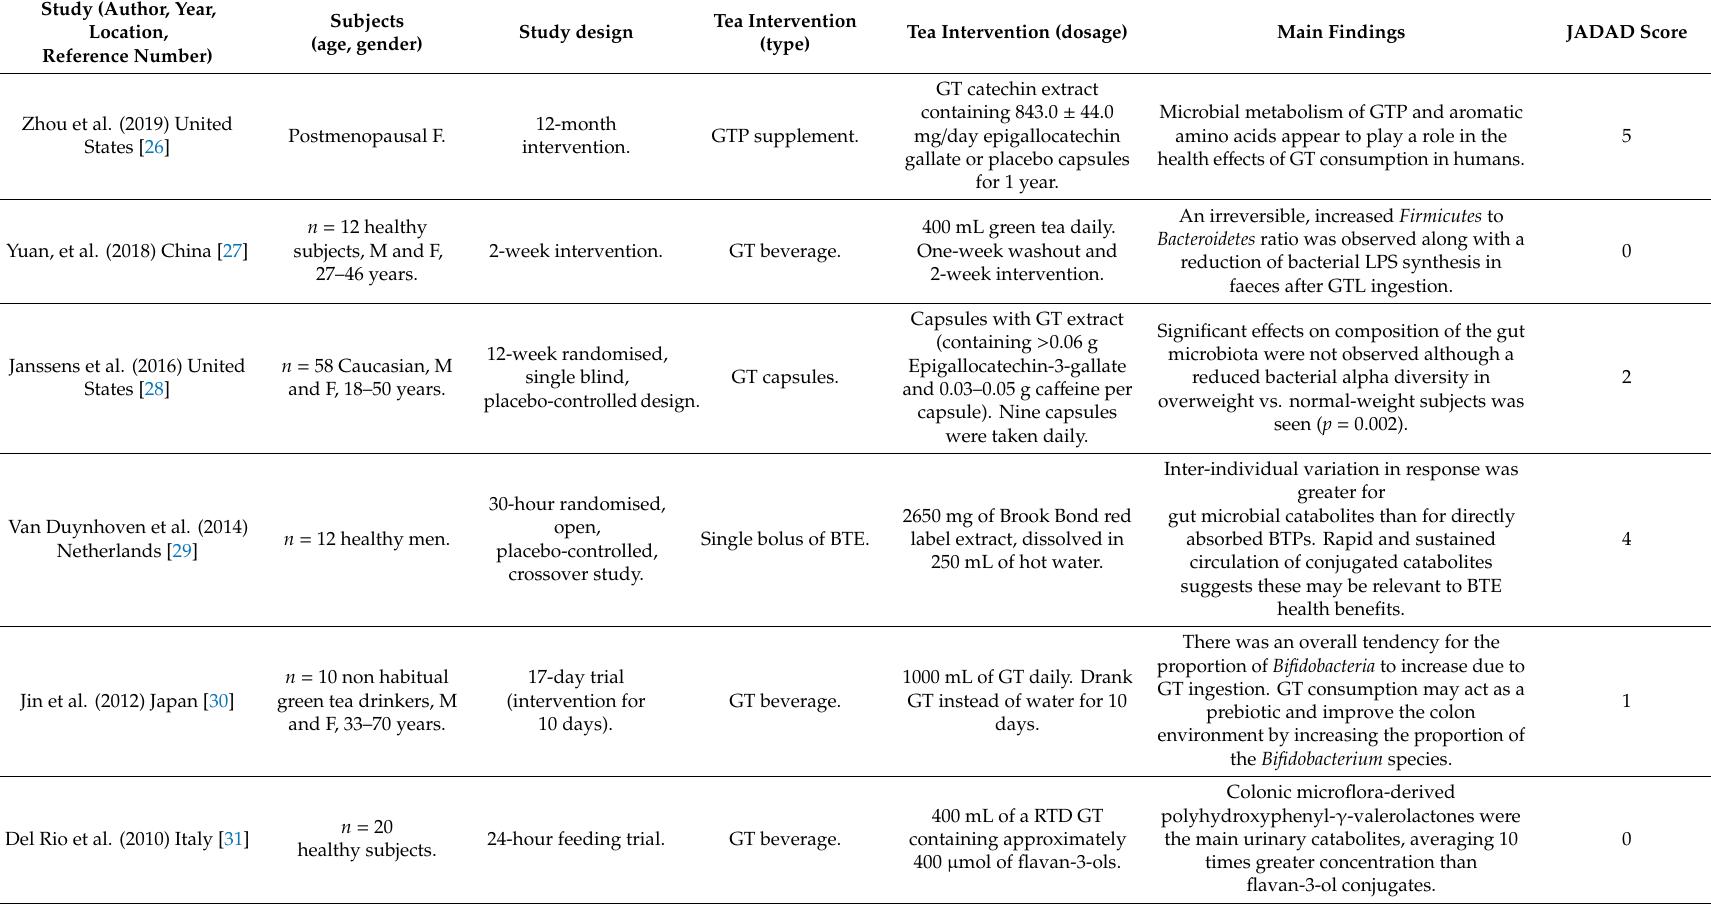
Table 2. Phase 1: Tea compounds and the gut microbiome: Evidence from human